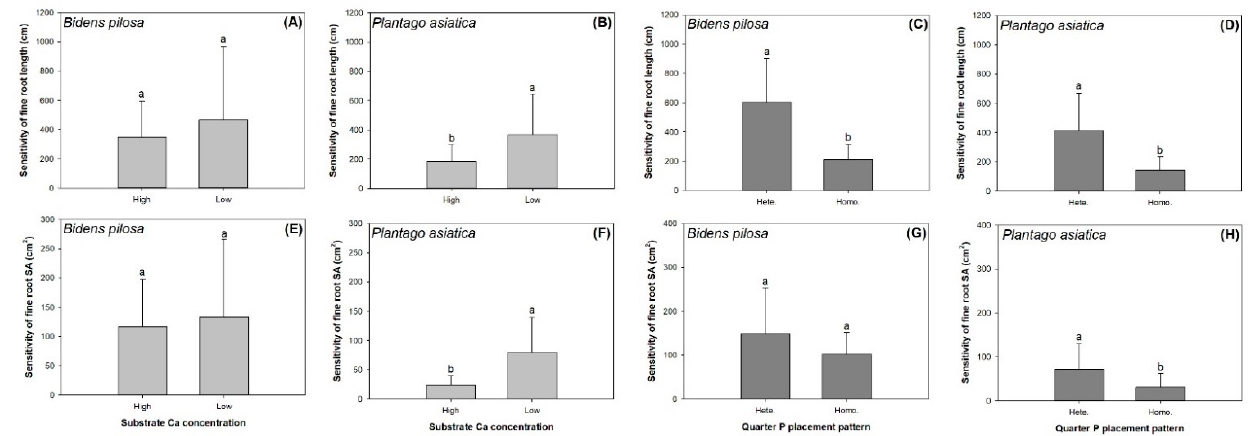
Figure 4. Fine root foraging sensitivity gauged as length ( A ‒ D ) and surface area (SA) ( E ‒ H ) in Bidens pilosa and Plantago asiatica plants subjected to phosphorus (P) input as heterogeneous (Hete.) and homogeneous patterns (Homo.) at high calcium (Ca) (2 g kg − 1 ) and low Ca levels (0.63 g kg − 1 ). Error bars stand for standard errors. Same letters in a cell of figure indicate the failure to find significant difference by Duncan’s new multiple range test at the p < 0.05 level.